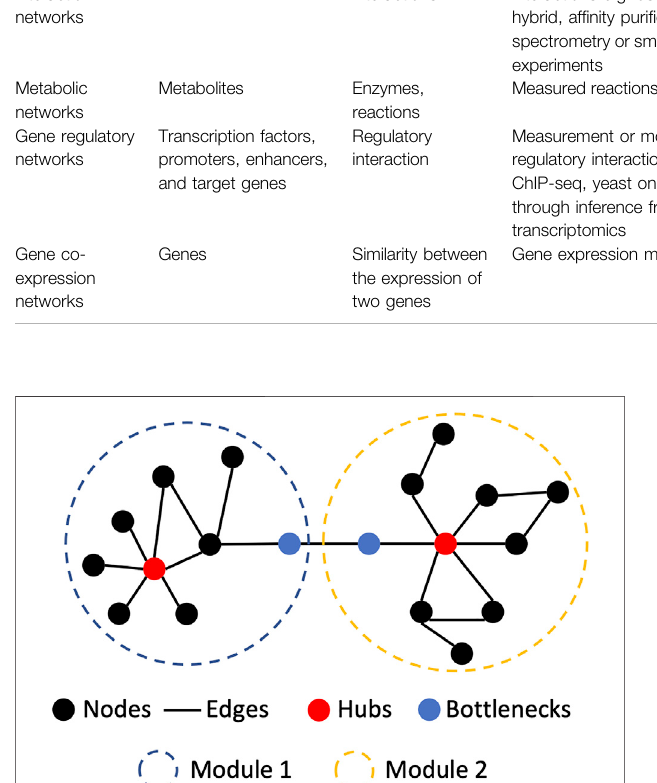
Frontiers in Genetics |